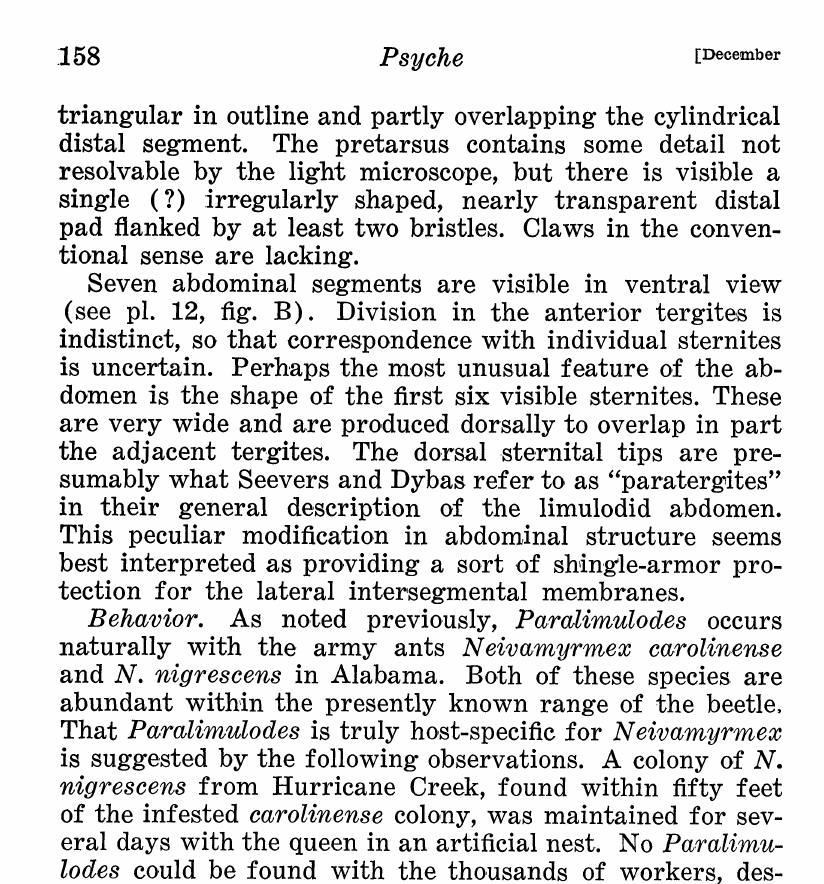
f, aedeagus tube, ventral view. Fig. g, spermatheca, ventral view. Fig. h, tarsus, including only structures clearly visible with the light micro- scope; terminal tarsal segment rotated to show pretarsus in dorsal